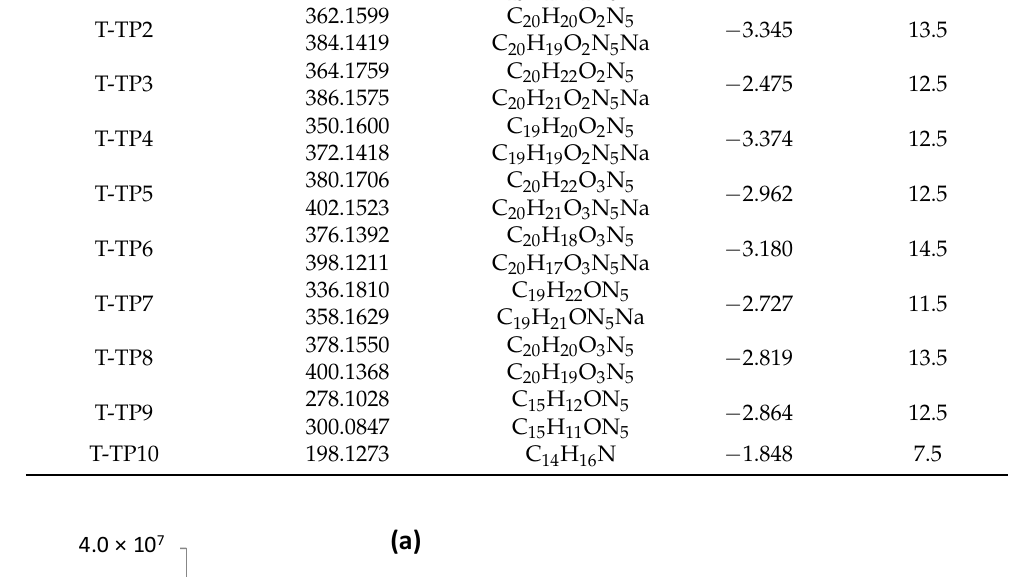
Table 2. UPLC-ESI(+)-HR-MS data (pseudo-molecular ions (M + H) + /(M + Na) + ; chemical formula; mass error ∆ (ppm); and ring-double bond equivalents, RDB) for VLS transformation products by TiO 2 photocatalytic oxidation.